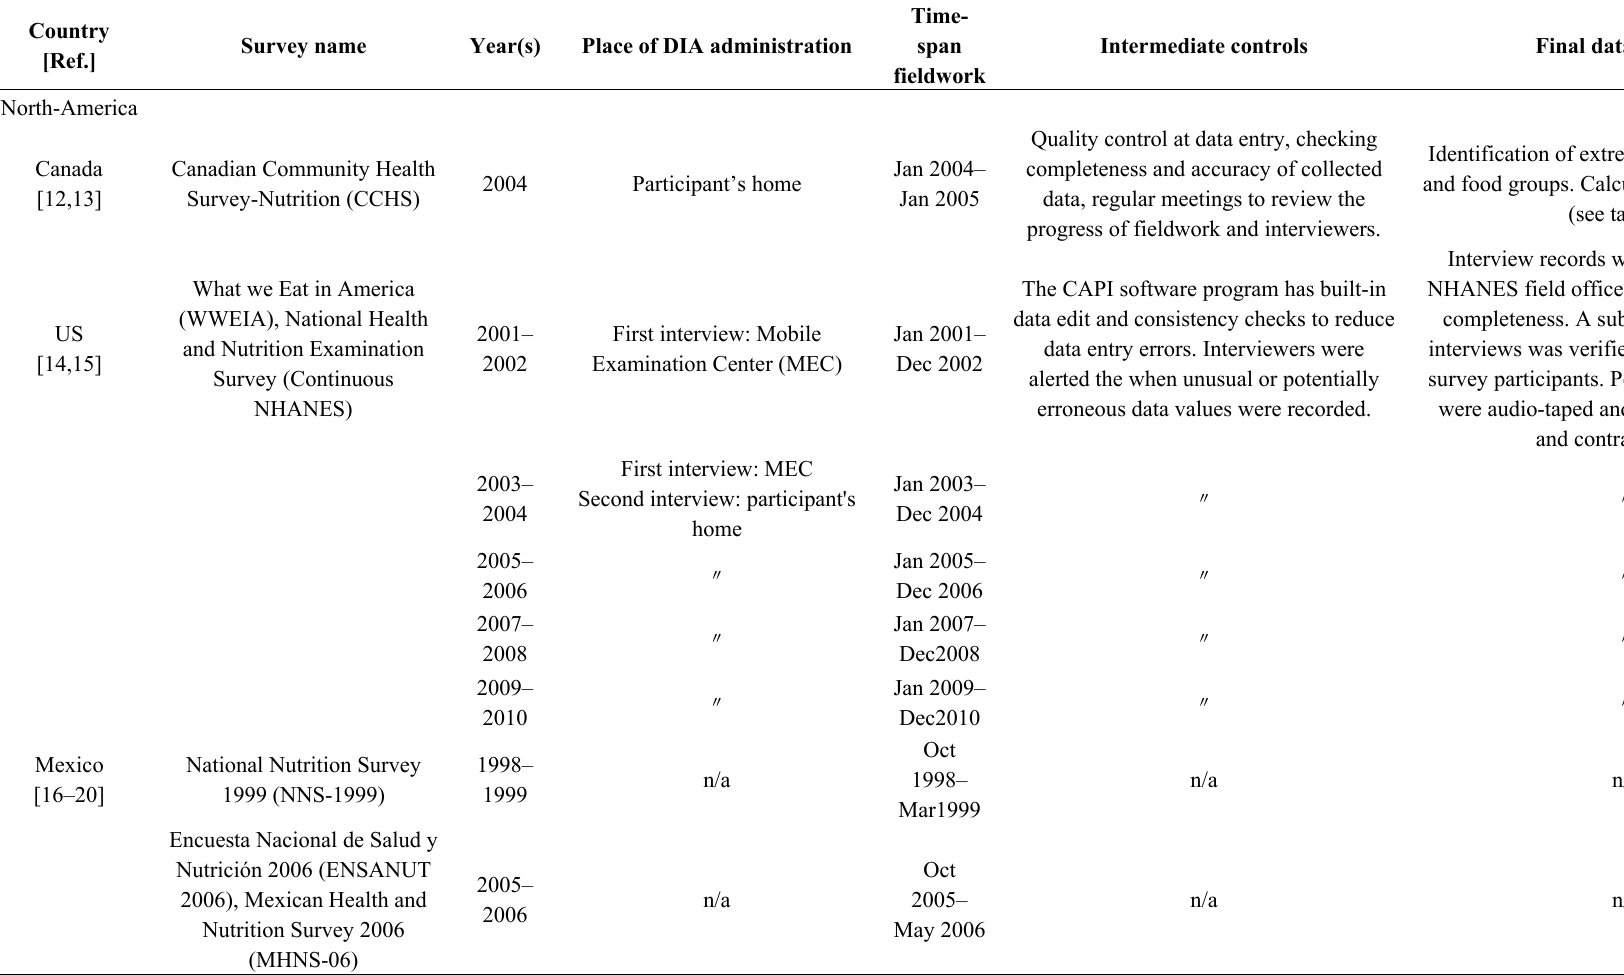
Table 5. Fieldwork characteristics and data controls of national nutrition surveys per